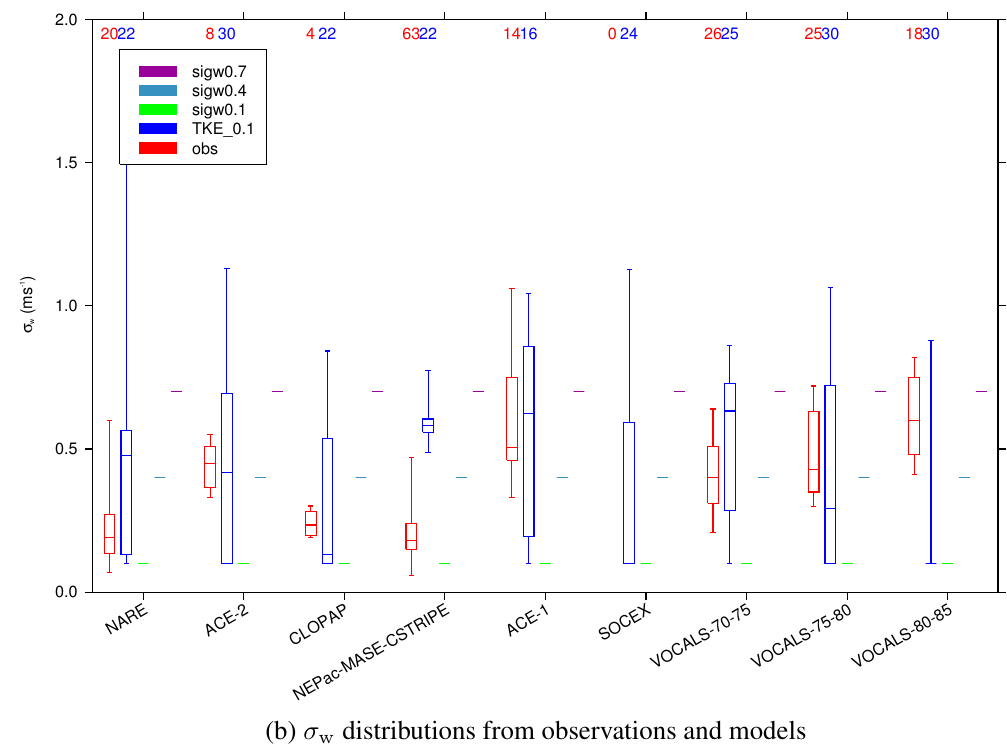
(b) σ w distributions from observations and models Fig. 7 : Continued, i.e. box-and-whisker-plots of (b) σ from flight campaign observations w (where reported) in red, and each model configuration (TKE_0.1 in blue, sigw0.1 in green; sigw0.4 in turquoise and sigw0.7 in purple) for marine stratiform flight campaigns. Note that in (b) appropriate fixed values of σ are plotted for experiments sigw0.1, sigw0.4, and sigw0.7, w for comparison purposes. Sample size is given across the top of each